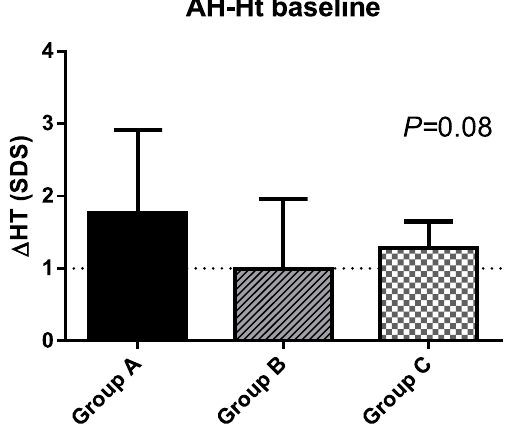
Figure 1. Height gain (∆HT) at adult height (AH) in the three groups of pre-pubertal patients.